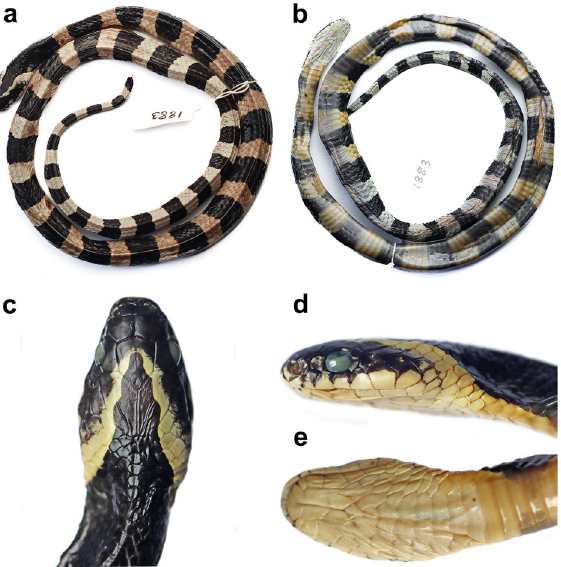
Figure 3. Bungarus fasciatus sensu stricto (MZMU1883) from Northeast India: ( a ) dorsal view of full body, ( b ) ventral view of full body, ( c ) dorsal view of head, ( d ) lateral view of the left side of head, and ( e ) ventral view of head.